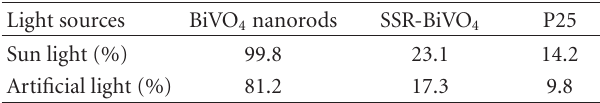
Table 3: E ff ect of light sources upon the photocatalytic proper- 90min light irradiation).